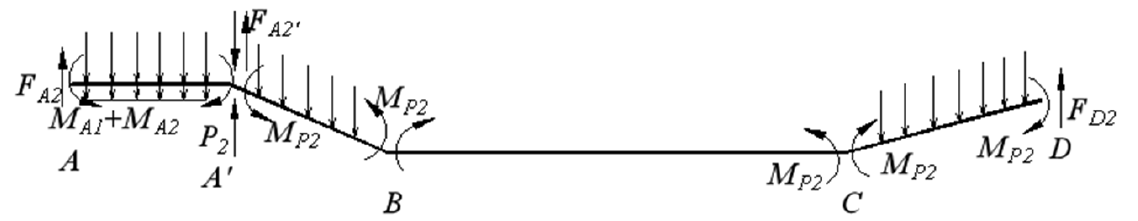
Figure 7. The mechanical model of the second layer of